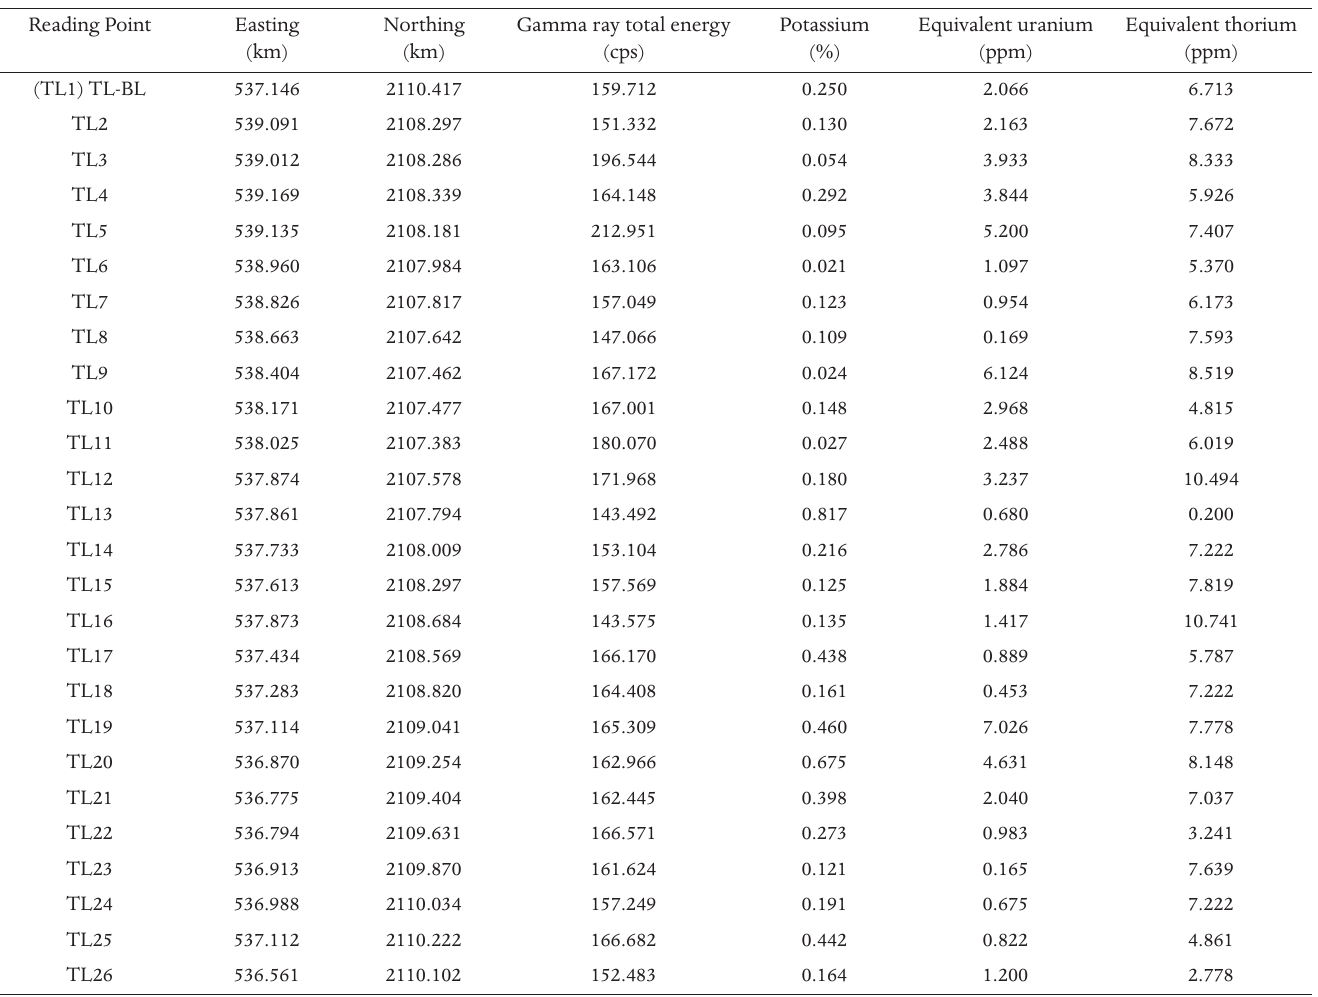
Table 1. Gamma-ray analysis results (total counts above 0.08